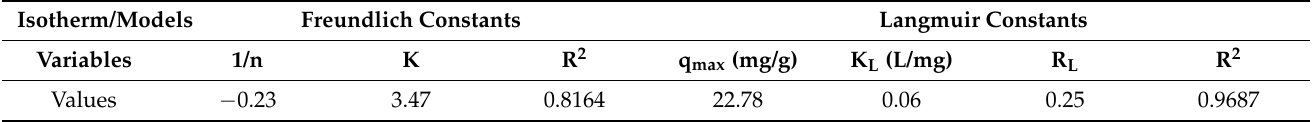
Table 5. Comparison of 2,4-D Langmuir adsorption capacities of different adsorbents.